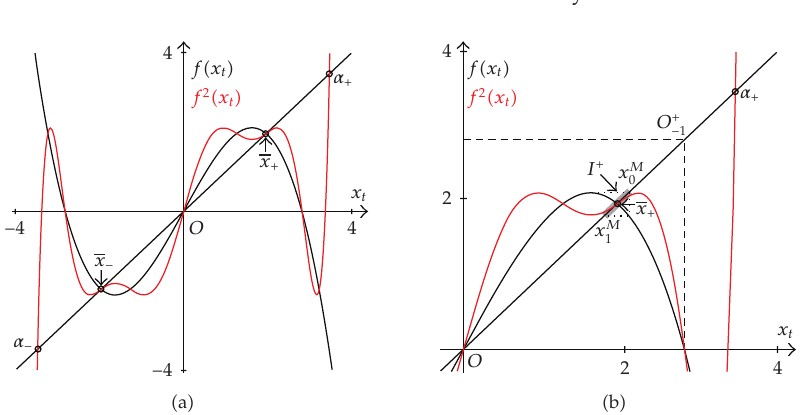
Figure 1: Stable non-fundamental steady states. (cid:5) a (cid:6) and its enlargement (cid:5) b (cid:6) are obtained using the following set of parameters: d (cid:8) 0 . 35, e (cid:8) 2 . 687, and f (cid:8) 0 . 7.